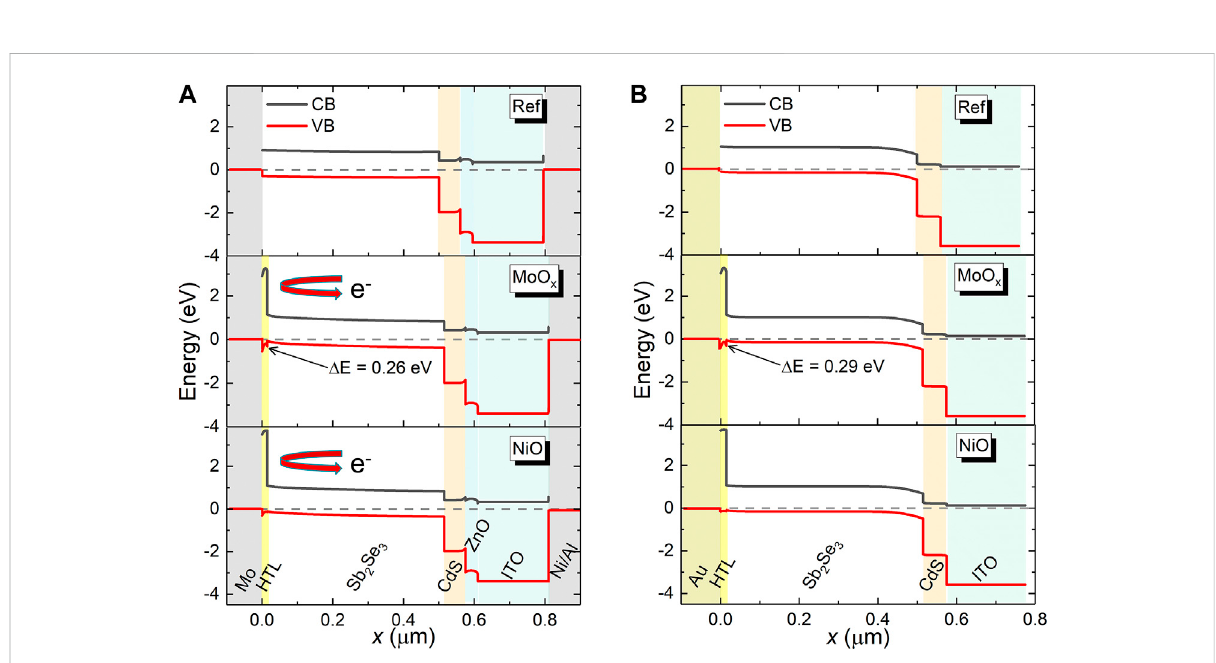
FIGURE 4 Energylevelalignmentforthedevicesinsubstrate (A) andsuperstrate (B) orientati1ons.Deviceswithoutaholetransportlayer(top),withaMoO x layer (middle) and a NiO layer (bottom) are